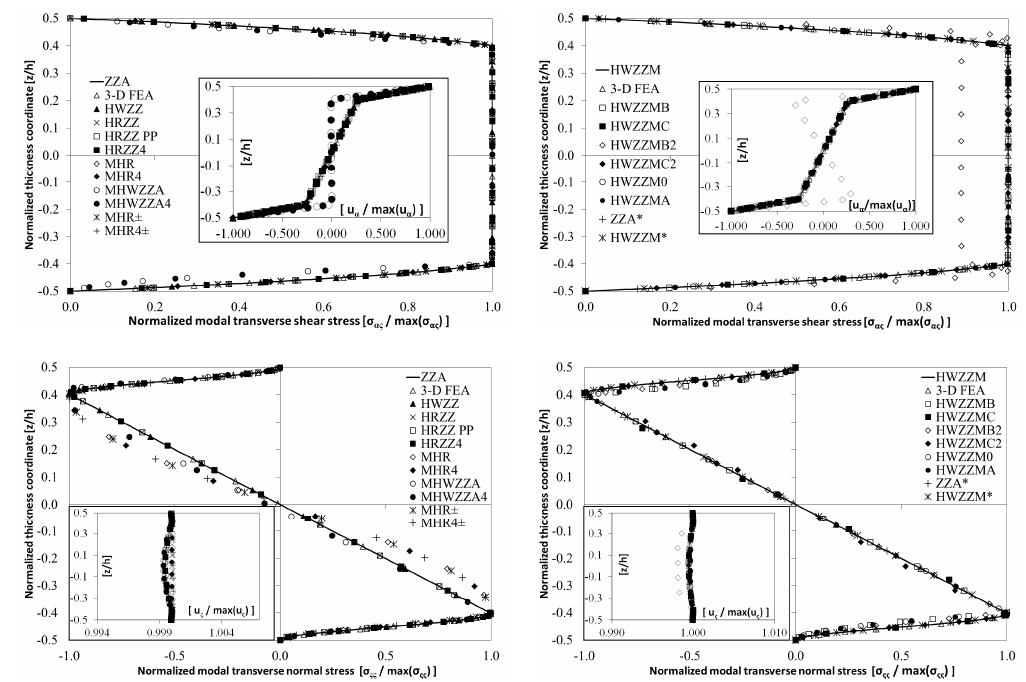
Figure 5. Case b3: Normalized modal displacements and stresses of a simply supported sandwich plate in cylindrical bending ( L x/ h = 20).